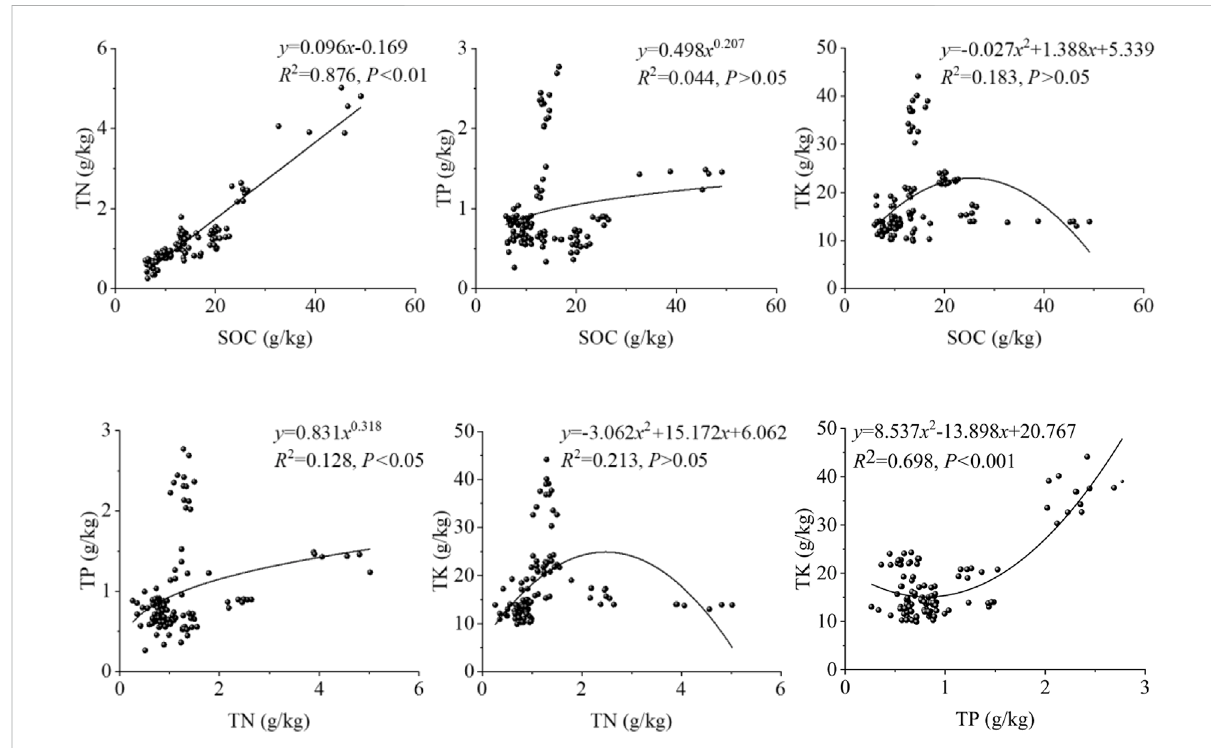
FIGURE 5 Correlations between soil C, N, P, and K contents.